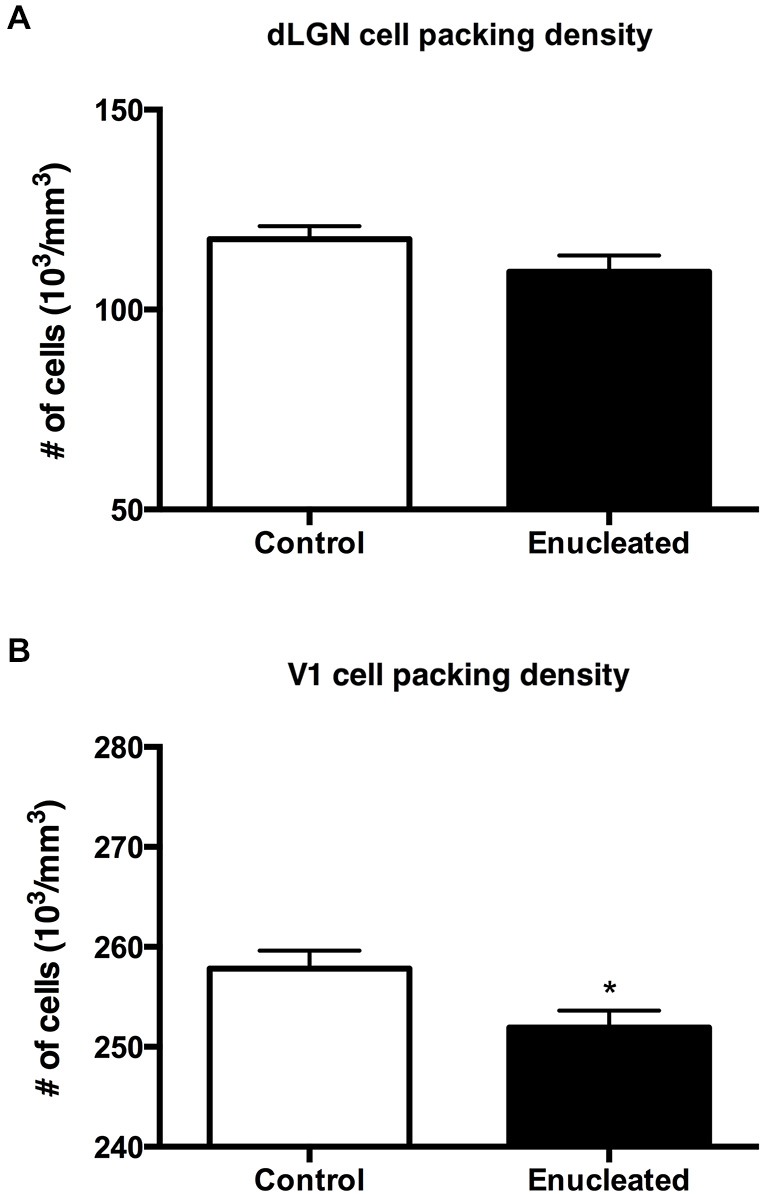
Summary cell density graphs. Graphs showing packing density (expressed as cells × 103) of cell nuclei from coronal sections in V1 and dLGN. (A) Cell packing density within the dLGN of enucleated mice does not significantly differ from that of controls (control 117.6 ± 3.206; enucleated 109.5 ± 4.065; P > 0.05). (B) Cell packing density within V1 of enucleated mice is significantly reduced when compared to controls (control 257 ± 1.793; enucleated 251.9 ± 1.714; *P < 0.05).